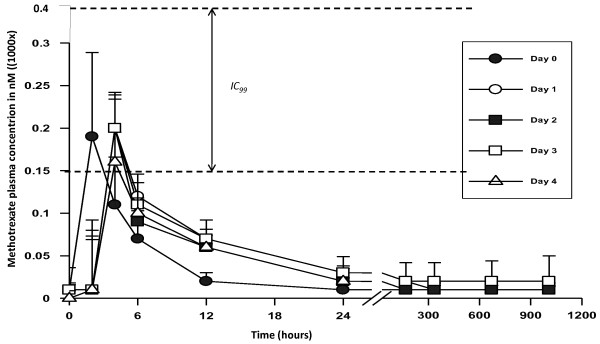
Methotrexate (MTX) plasma concentration from day 0 to day 4. Five participant provided blood each day, thus each point represents a mean of 5 measurements. IC99 represents MTX concentration that inhibits 99% of parasite growth in vitro.